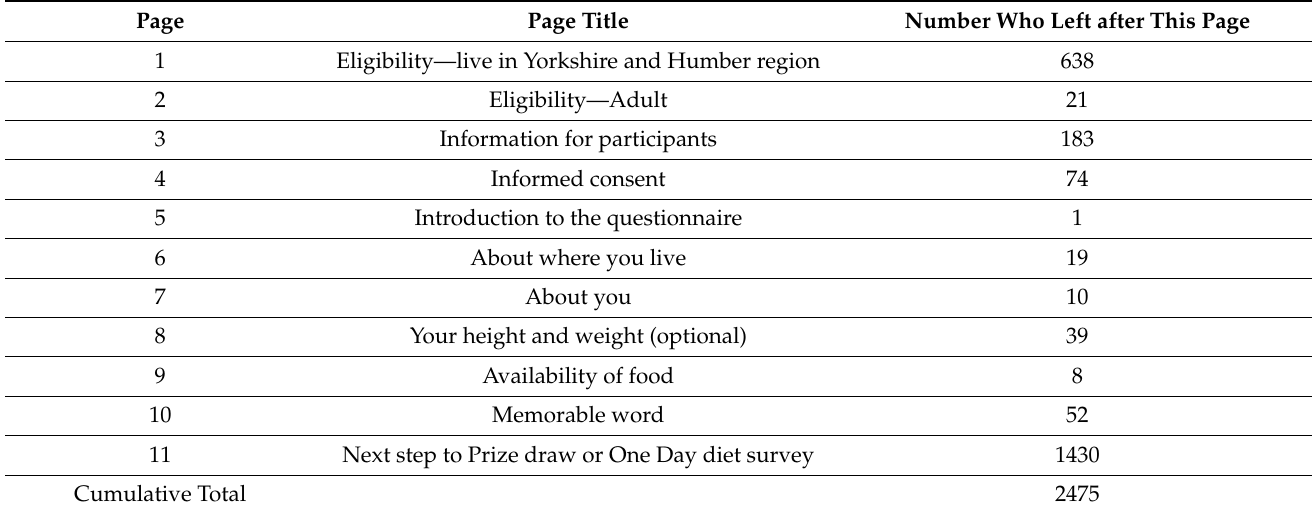
Table A1. Numbers leaving at each stage of the